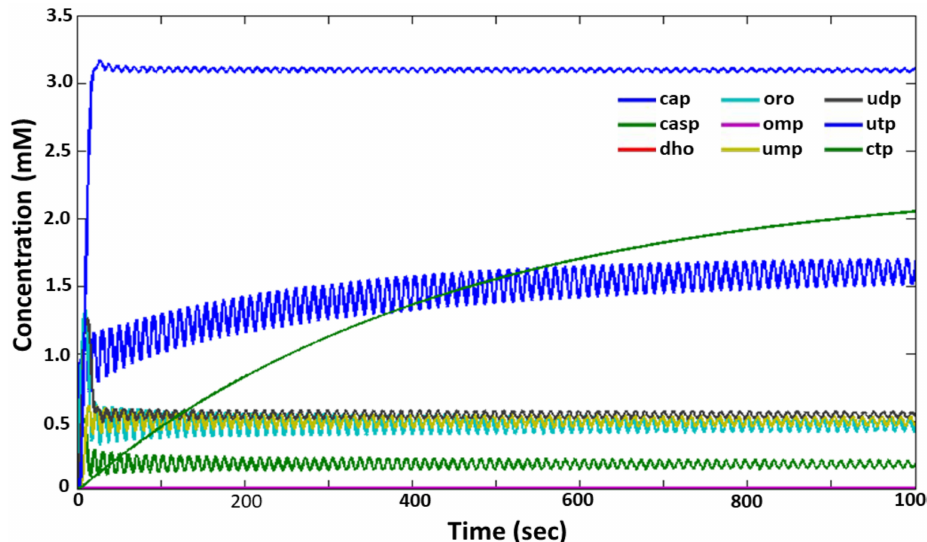
Figure 4. The oscillatory mode of functioning of the pyrimidine synthesis system in the DEEP model analysis ( h UMP1 = 6 and r = 0.28). Values of other parameters are given in Table S4 (column “best”, Supplementary Text S3). The X axis is time (sec), the Y axis is the concentration of metabolites (mM). The designations of metabolites and colors of their concentration curves are similar to those in Figure